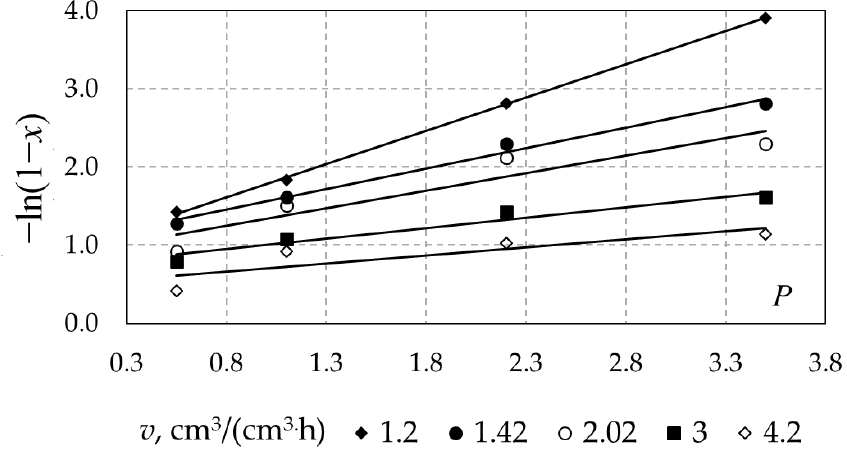
Figure 5. Dependence − ln(1 − x ) = f ( P ) for different values of volume rate of fuel supply ( υ Dependence − ln(1 − x ) = f ( P ) is approximated by a straight line, which indicates the adequacy of this equation to the experimental regularity. The constants of the parametric Equation (16) are α = 0 .806, β = 0 .42.